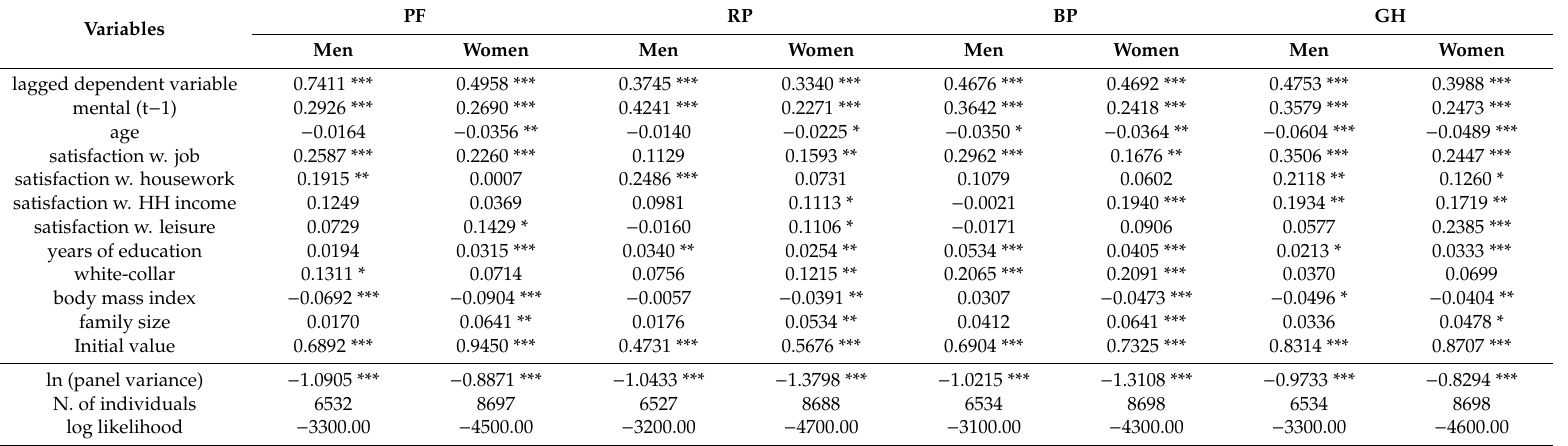
Table 4. Estimation results: coe ffi cient estimates of physical-related submeasures.